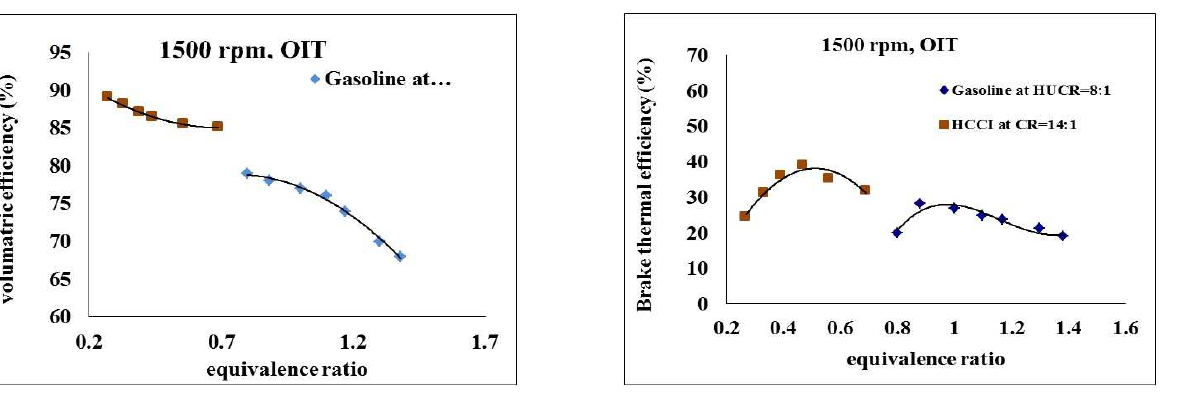
Fig. 8. Volumetric efficiency of the two systems at HUCR for each one, for wide range of equivalence ratio